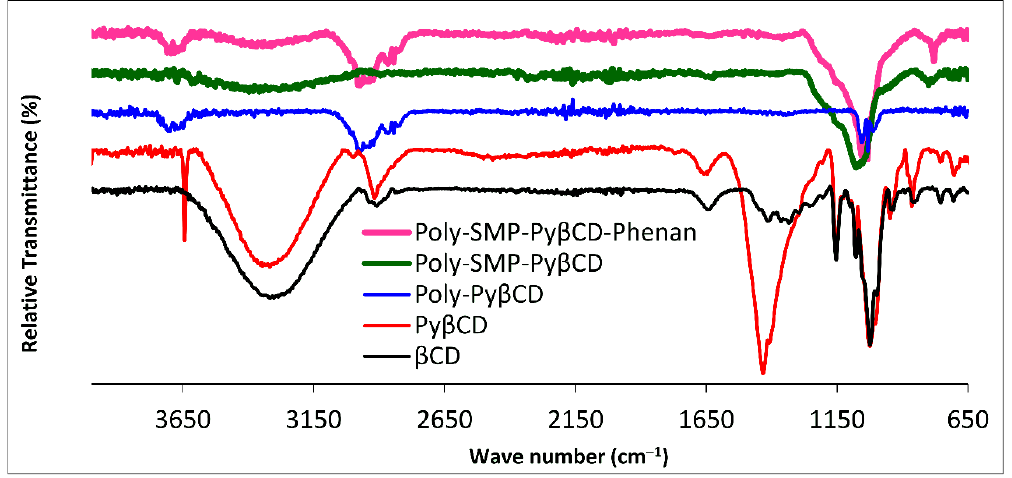
Figure 4. ATR-IR spectra of (respectively from bottom to top) βCD, PyβCD ( 2 ); Poly- PyβCD ( 3 ); Poly- SMP- PyβCD ( 4 ); and that of after making inclusion complex with the phenanthrene. Thus, all vibrations and bends of the βCD were shifted to lower frequenc ies after